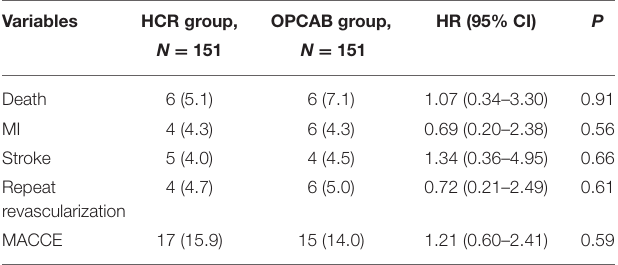
TABLE 5 | Midterm outcomes of matched patients who underwent HCR and